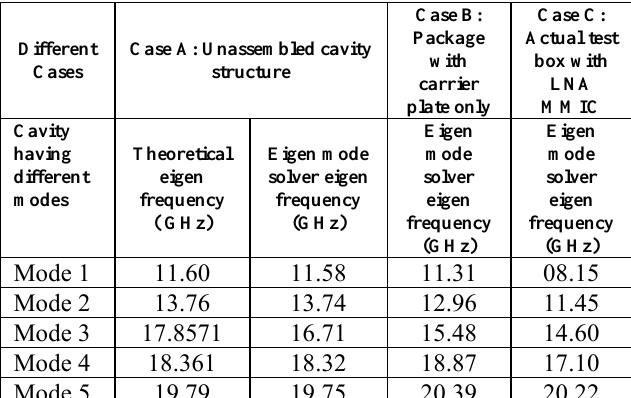
Table 1. Different Cases: Eigen mode analysis results for (a) unassembled cavity structure (b) Package/house with carrier plate only and (c) Actual